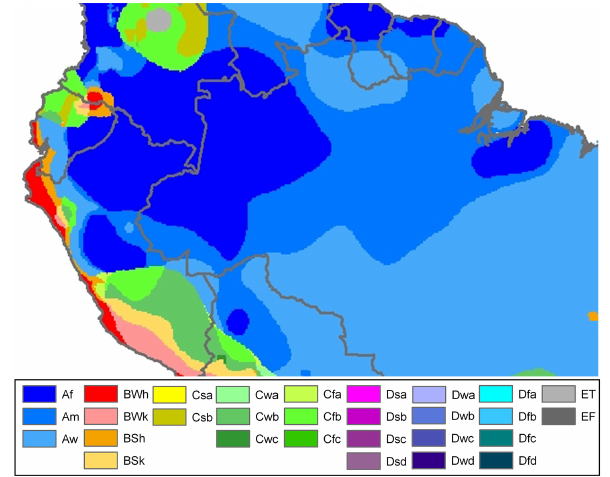
Figure 2. Köppen–Geiger climate zones in the study area (source: Peel et al.,